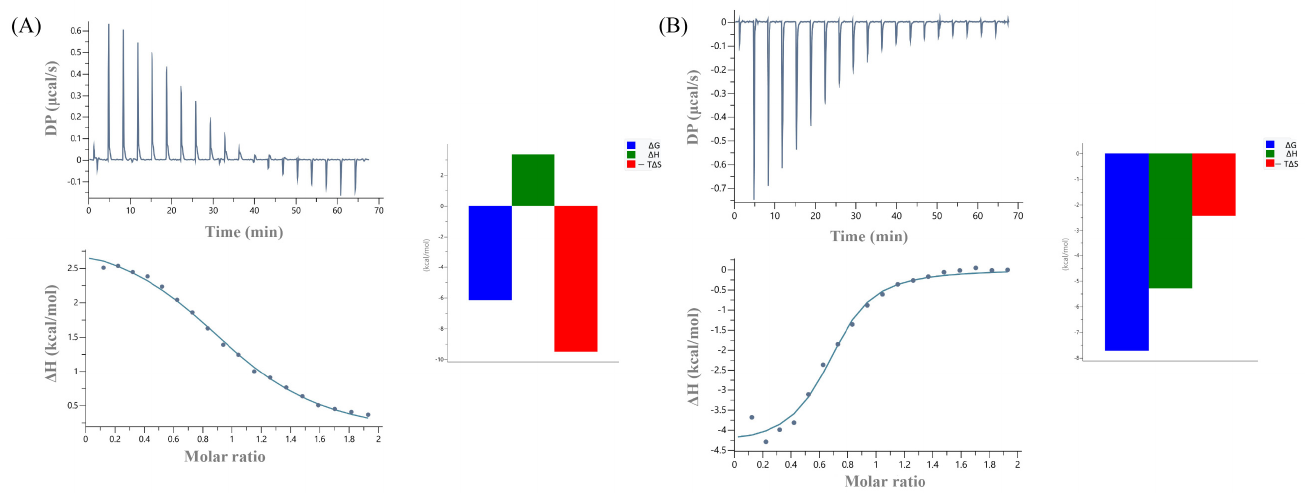
Figure 7. ITC data for the titration of UBCH5B into ( A ) Arkadia 68 aa and ( B ) Arkadia 119